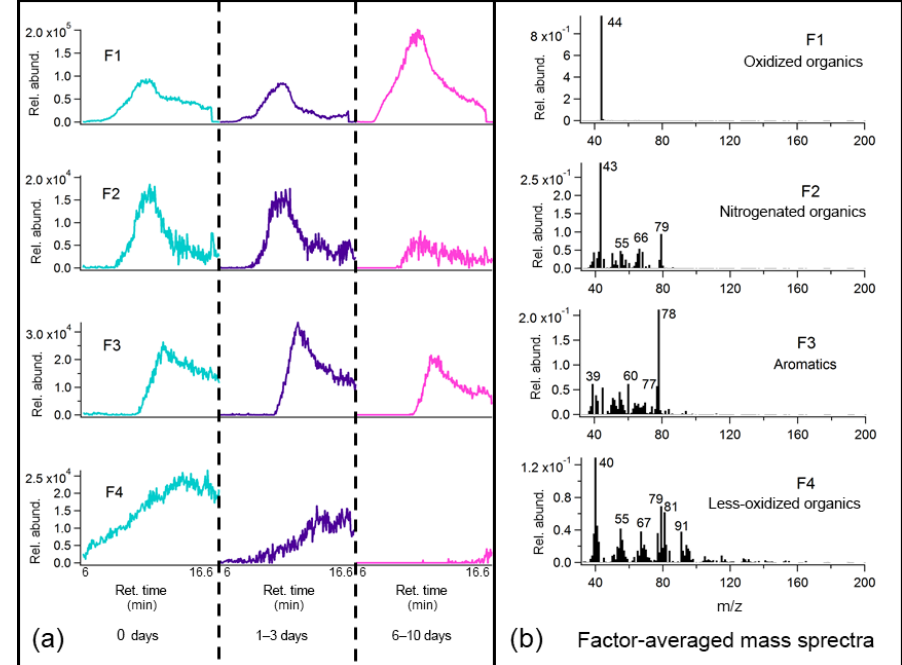
Figure 9. Average binned chromatograms and mass spectra for factors 1–4 (F1–4) in PMF 4-factor solution on TAG oak leaf BBOA de- composition window data. Relevant plots obtained in PMF calculations are provided in the Supplement (Figs. S12c and S13c). These chromatograms were obtained from PMF calculations by averaging binned data corresponding to triplicate chromatograms at each level of oxidation. The triplicate-averaged binned chromatograms at each equivalent aging time are displayed in one trace; different aging times are demarcated with vertical lines across the x